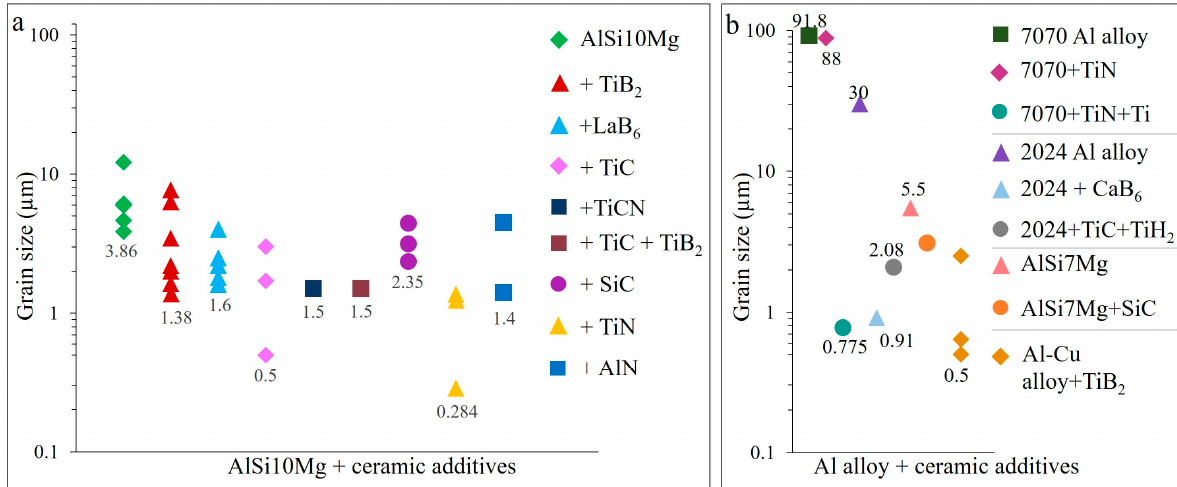
Figure 26. Average grain size of LPBF prepared ceramic particulate reinforced AlSi10Mg ( a ) and other Al alloys ( b ) (data from [8,28,31,50,59,66,67,73,77–84,88,91–93,96,99–101]).